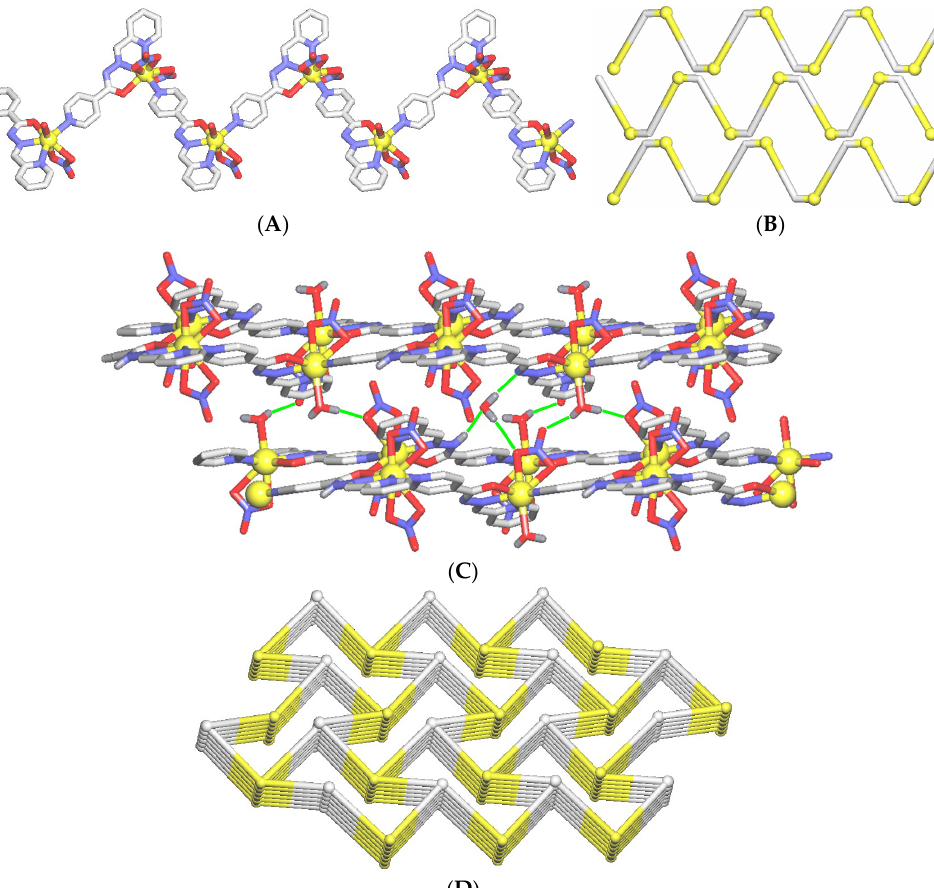
Figure 2. Representation of ( A ) dodecahedral and ( B ) monocapped trigonal-prismatic geometries of Cd1 and Cd2 atoms in 1 .